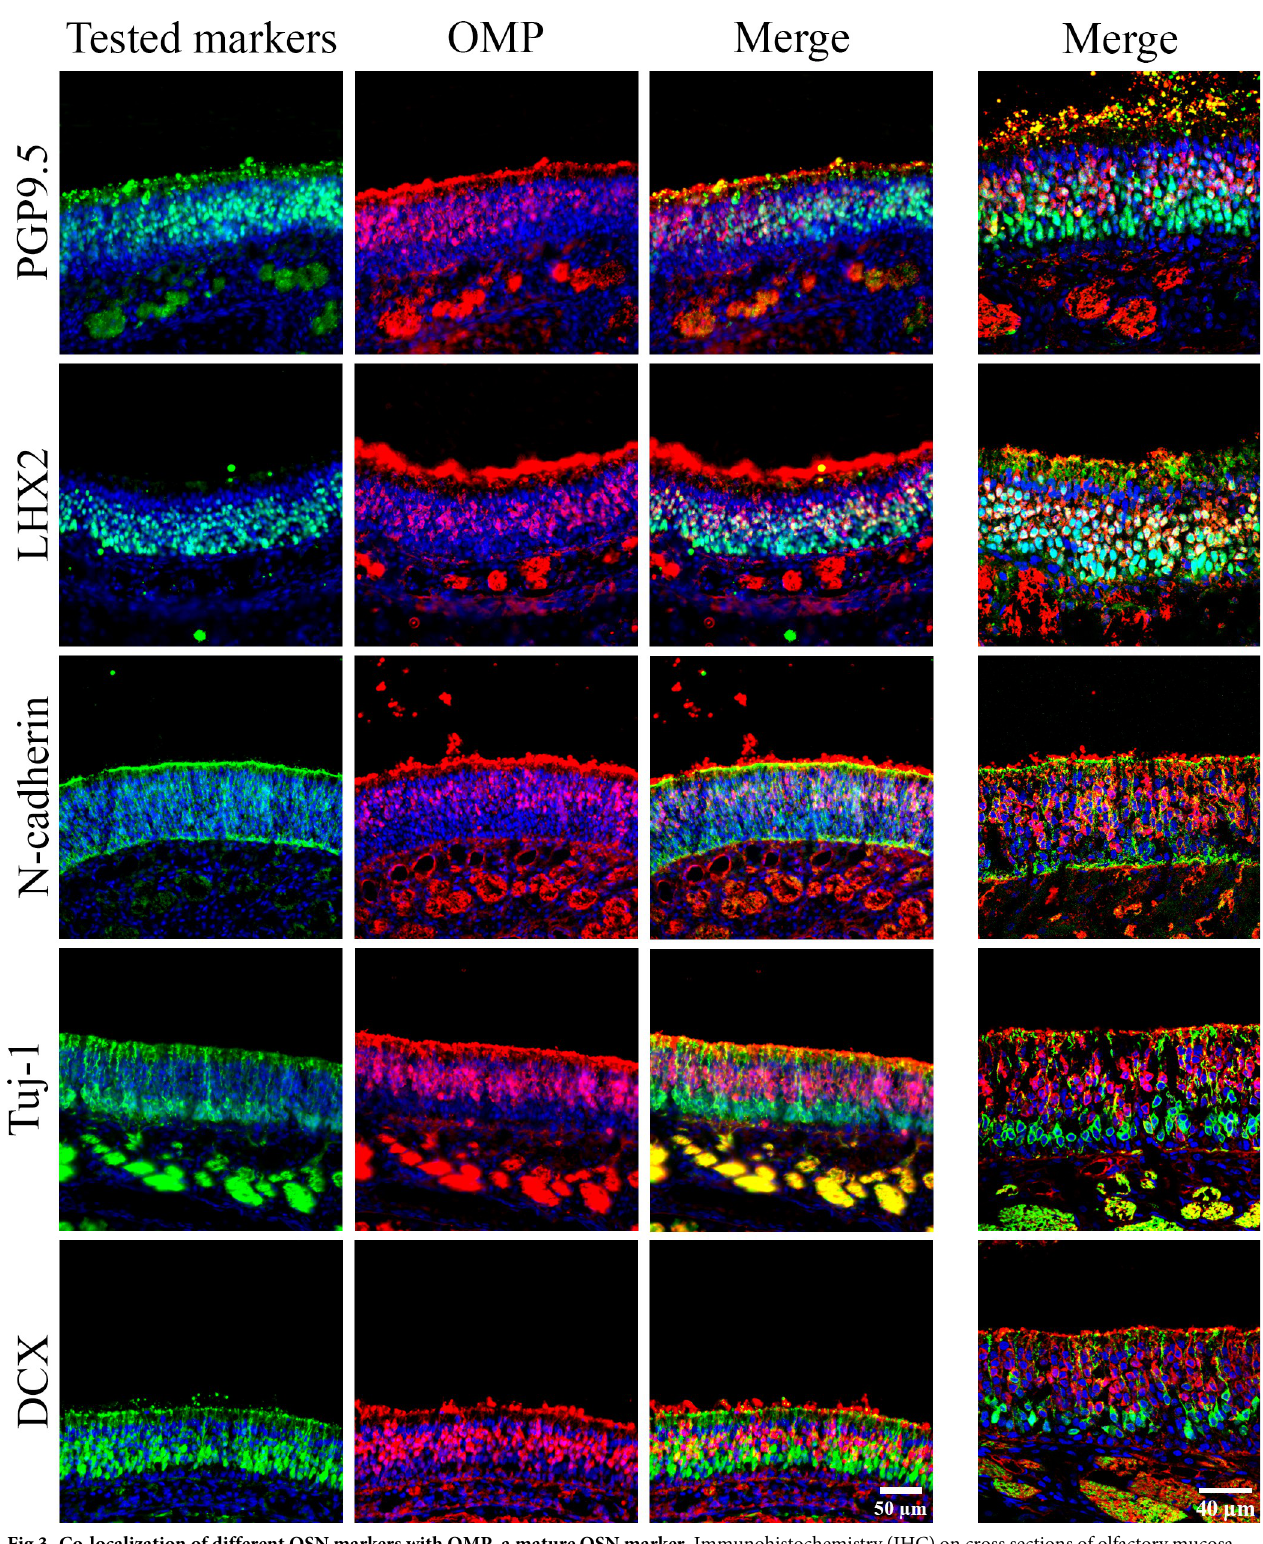
Fig 3. Co-localization of different OSN markers with OMP, a mature OSN marker. Immunohistochemistry (IHC) on cross sections of olfactory mucosa. The tested markers were colored in green and their name were noted on the left of each line of images. Due to the identical animal production between the anti-OMP antibody and anti-OliG2, we could not double label these two markers. The nuclei were stained in blue using DAPI. The images in the 3 left